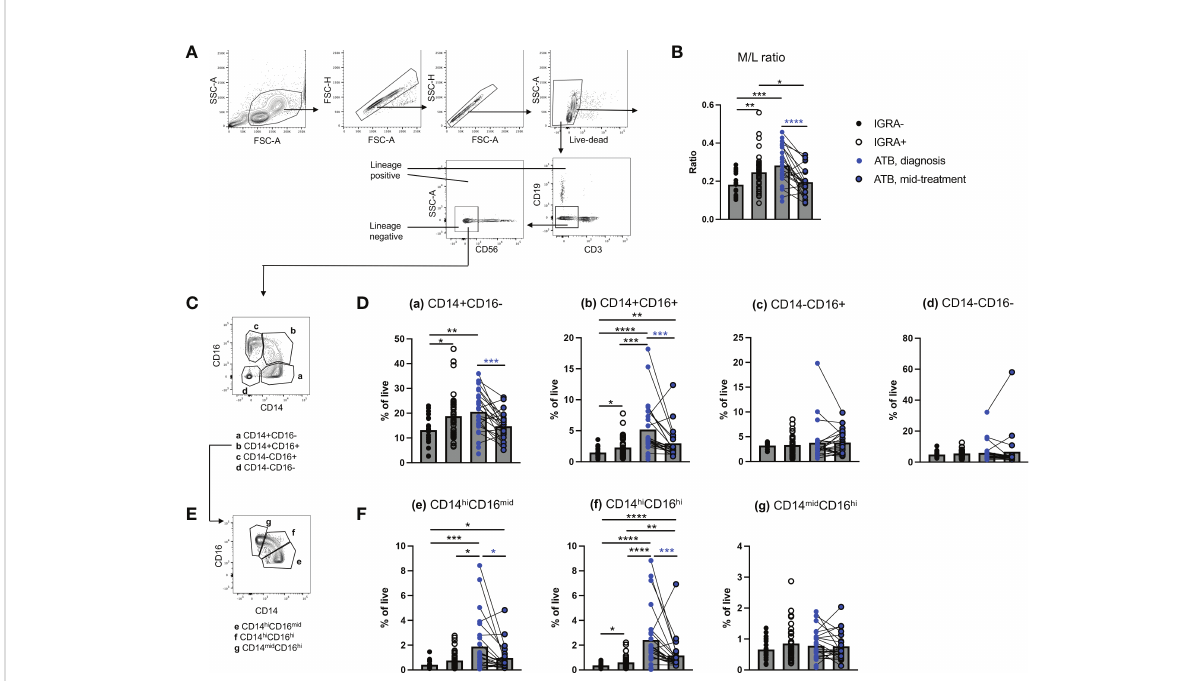
FIGURE 1 Increased frequency of circulating classical CD14 + CD16 - and intermediate CD14 + CD16 + monocytes in ATB at diagnosis. (A) Gating strategy to calculate the monocyte to lymphocyte (M/L) ratio based on the negative or positive expression of lymphocyte lineage markers using fl ow cytometry. (B) M/L ratio in active TB (ATB) at diagnosis, ATB mid-treatment, IGRA+ and IGRA- cohorts. (C) Gating strategy to identify CD14/ CD16 sub-populations from the lymphocyte lineage negative population identi fi ed in Figure 1A. (D) Frequency of lineage negative CD14 + CD16 - , CD14 + CD16 + , CD14 - CD16 + and CD14 - CD16 - cells in ATB diagnosis, ATB mid-treatment, IGRA+ and IGRA- cohorts. (E) Gating strategy to identify CD14/CD16 sub-populations within intermediate CD14 + CD16 + monocytes identi fi ed in Figure 1C. (F) Frequency of CD14 hi CD16 mid , CD14 hi CD16 hi and CD14 mid CD16 hi monocytes in ATB diagnosis, ATB mid-treatment, IGRA+ and IGRA- cohorts. Data was from cryopreserved PBMC of 25 ATB subjects at diagnosis (with 22 paired mid-treatment samples), 40 IGRA+ and 20 IGRA- individuals. *p < 0.05, **p < 0.01, ***p < 0.001, ****p < 0.0001, nonparametric unpaired Mann-Whitney U test (black stars) and nonparametric paired Wilcoxon test (blue